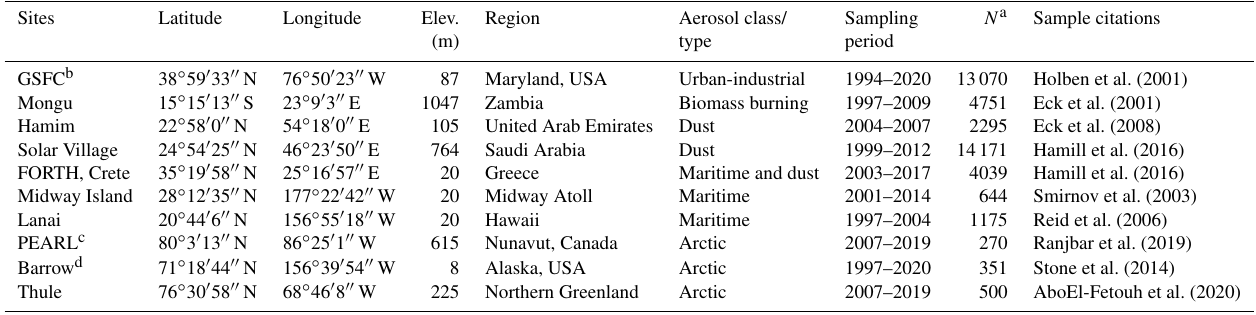
Table 1. Site coordinates, predominant aerosol type, sampling periods and retrieval numbers for the AERONET inversions and SDA retrievals employed in this study.